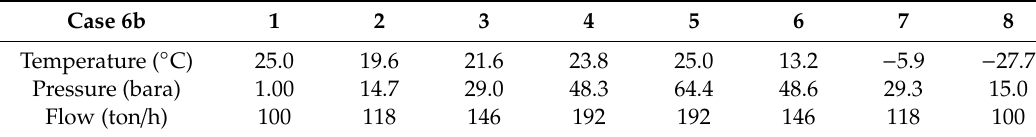
Table A13. Mass balance for Case 6b, stream numbering from Figure